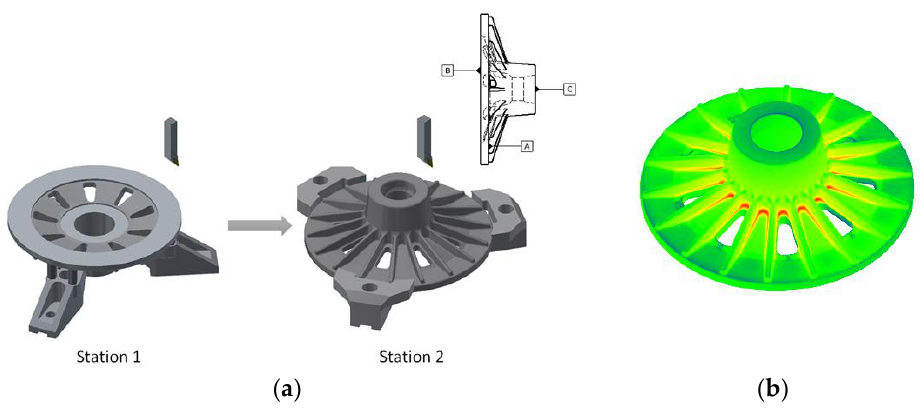
Figure 12. A manufacturing process and part considered for study. ( a ) A two-stage truck component setup; ( b ) a scanned model of a machined part in station 2. Table 1. Factors and responses of a DOE for station 2, with fixture parallelism error of 0.03 mm. # Exp.